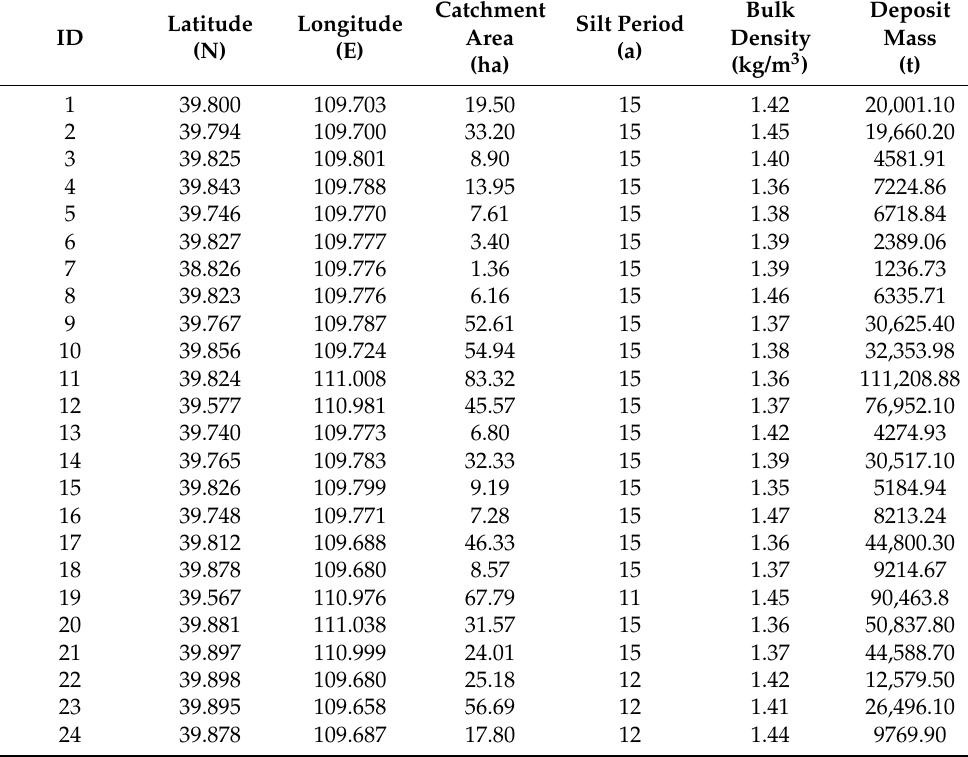
Table 1. The general information for the check dams in the Pisha sandstone